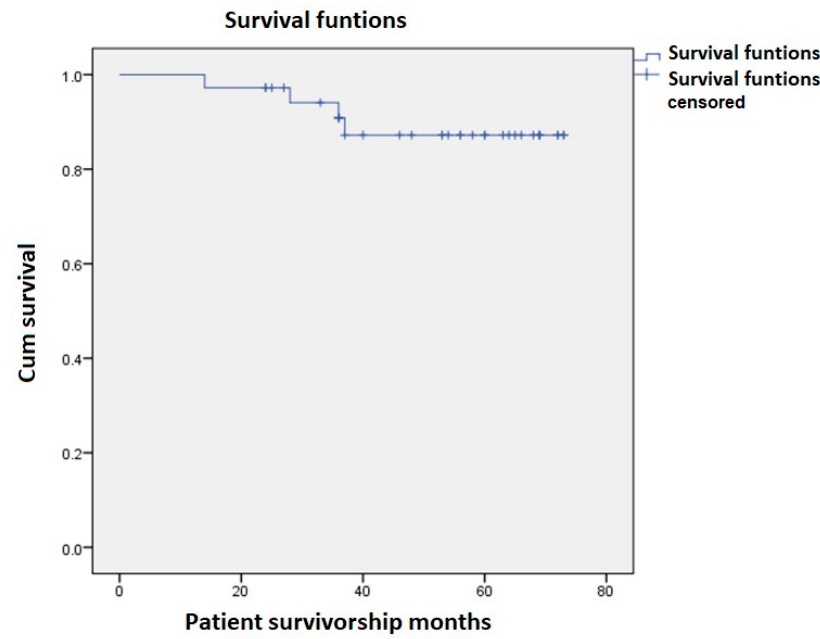
Figure 1. Kaplan–Meier patient survivorship.